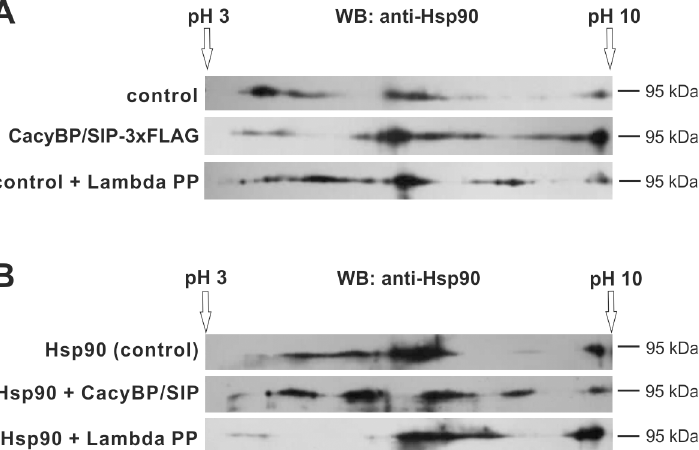
Fig 9. Pattern of spots representing Hsp90 forms with different pI values. (A) Pattern of Hsp90 spots in HEp-2 cell lysate. Upper panel: HEp-2 cells co-transfected with plasmids encoding Hsp90 β -3xFLAG and 3xFLAG (control). Middle panel: HEp-2 cells co-transfected with plasmids encoding Hsp90 β -3xFLAG and CacyBP/SIP-3xFLAG. Bottom panel: HEp-2 cells co-transfected with plasmids encoding Hsp90 β -3xFLAG and 3xFLAG (control) but lysate was incubated with Lambda Protein Phosphatase (Lambda PP). ( B) Pattern of spots corresponding to purified Hsp90. Upper panel: Hsp90 (control). Middle panel: Hsp90 incubated with recombinant CacyBP/SIP. Bottom panel: Hsp90 incubated with Lambda Protein Phosphatase (Lambda PP). A representative Western blot, out of 3 performed after two dimensional (2D) electrophoresis, is